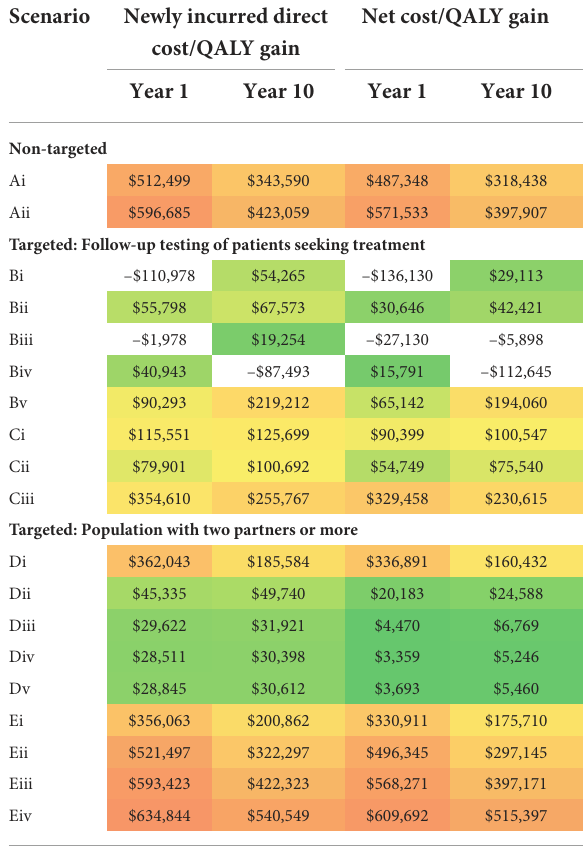
at the end of the burn-in period and 2.01 ± 0.20% during the 10th year of the intervention. On the other hand, the mean prevalence of the burn-in period for scenario Di (targeted screening: 2 partners or more, 10% of the population screened per year) was 3.35 ± 0.38% during its last year and decreased to 2.35 ± 0.21% during the 10th year of